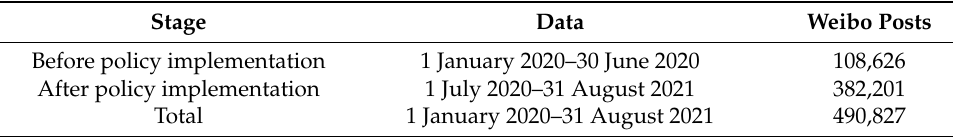
Table 2. Number of comments on Sina